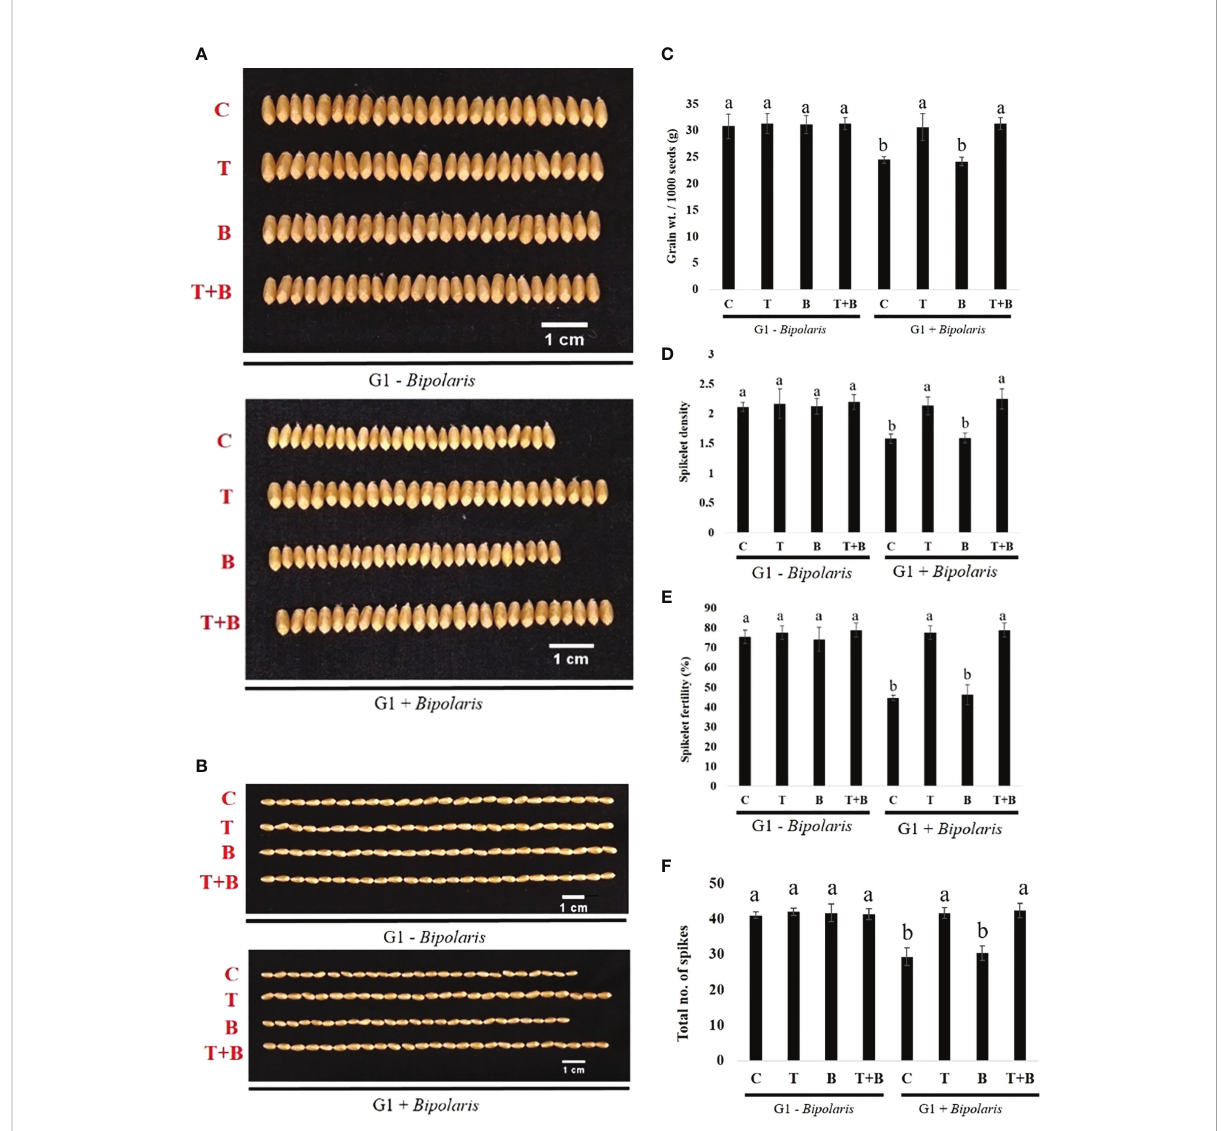
FIGURE 8 Effect of intergenerational immune priming on the yield of the G1 wheat after challenging with Bipolaris sorokiniana HD 3069. (A) Grain width. Scale bar = 1 cm, n = 25, (B) Grain length. Scale bar = 1 cm, n = 25, (C) Gram weight / 1000 seeds (n = 1000) (D) Spikelet density, (E) Spikelet fertility and (F) Total no. of spikes of wheat after challenging with Bipolaris . C = control, T Trichoderma -primed, B = Nonprimed wheat challenged with Bipolaris , T+B = Trichoderma -primed and challenged with Bipolaris . Data in (C – F) are represented as mean ± SD and different alphabets indicate statistically signi fi cant difference at P<0.05 in Tukey's test. Results are representatives of three independent biological replicates. (n =